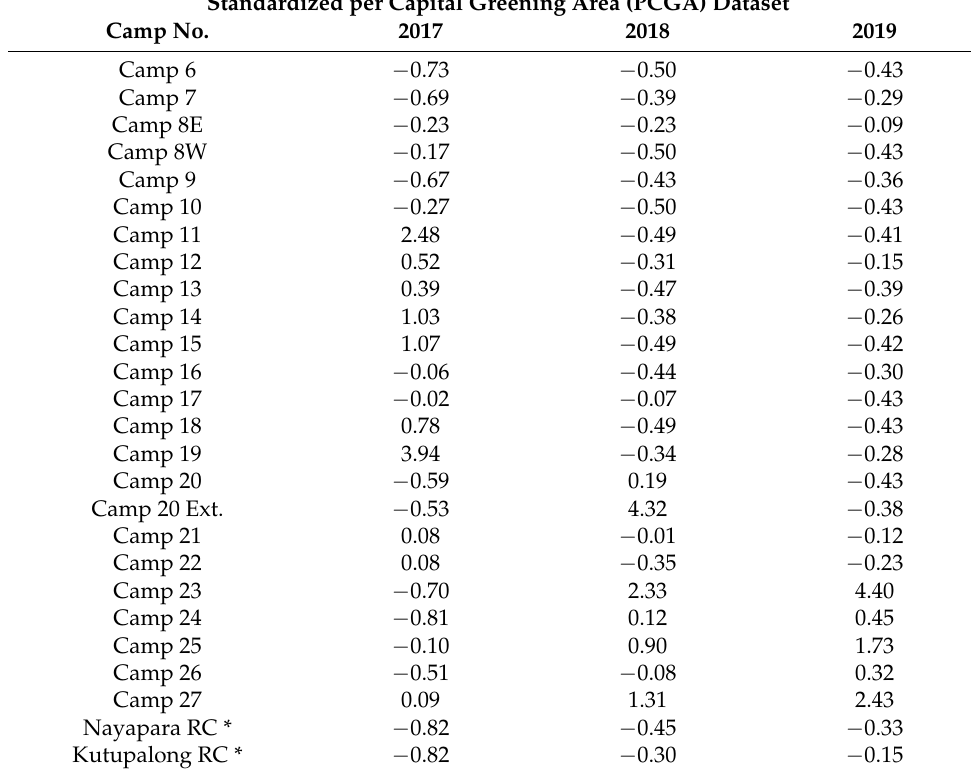
Table A2. Cont . Standardized per Capital Greening Area (PCGA) Dataset